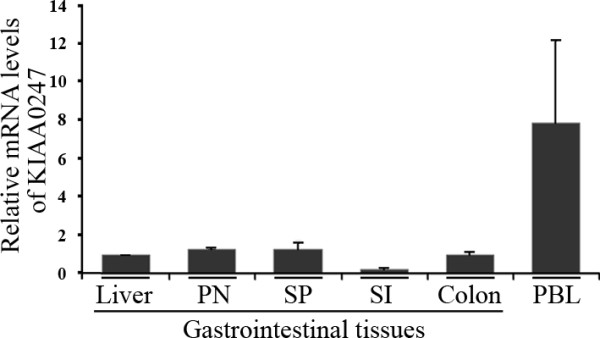
Relative KIAA0247 mRNA levels in gastrointestinal tissues. KIAA0247 mRNA levels quantified and normalized by individual levels of 18S rRNA. The organs of gastrointestinal tissues include the liver, pancreas (PN), spleen (SP), small intestine (SI), and colon. PBL, peripheral blood lymphocyte. Each KIA0247 mRNA level is relative to that in the liver. Data are representative of three independent experimental repeats.